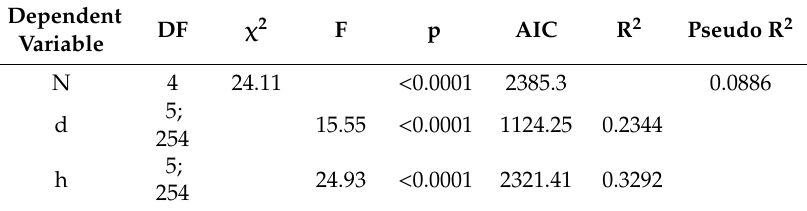
Table 2. Goodness of fit characteristics of the selected models.